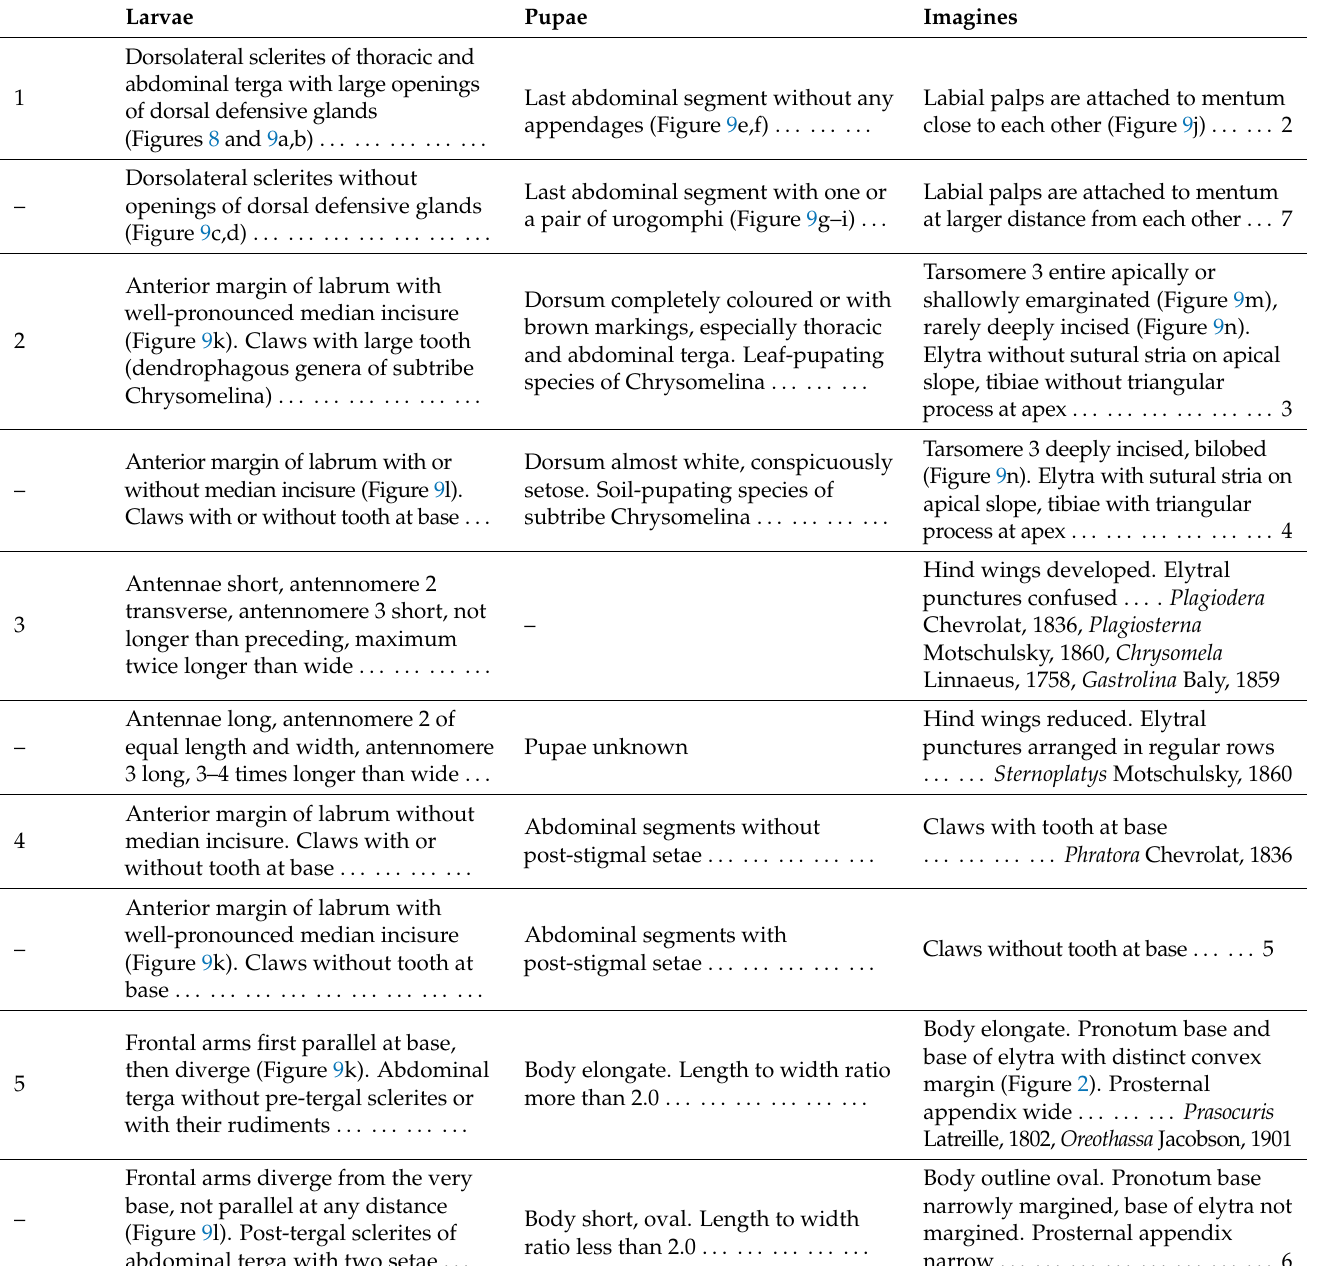
Table 1. Triple key for the Palaearctic genera of Chrysomelini combining the characters of larvae, pupae and adult beetles (includes only genera with known immature stages). Pupae Imagines